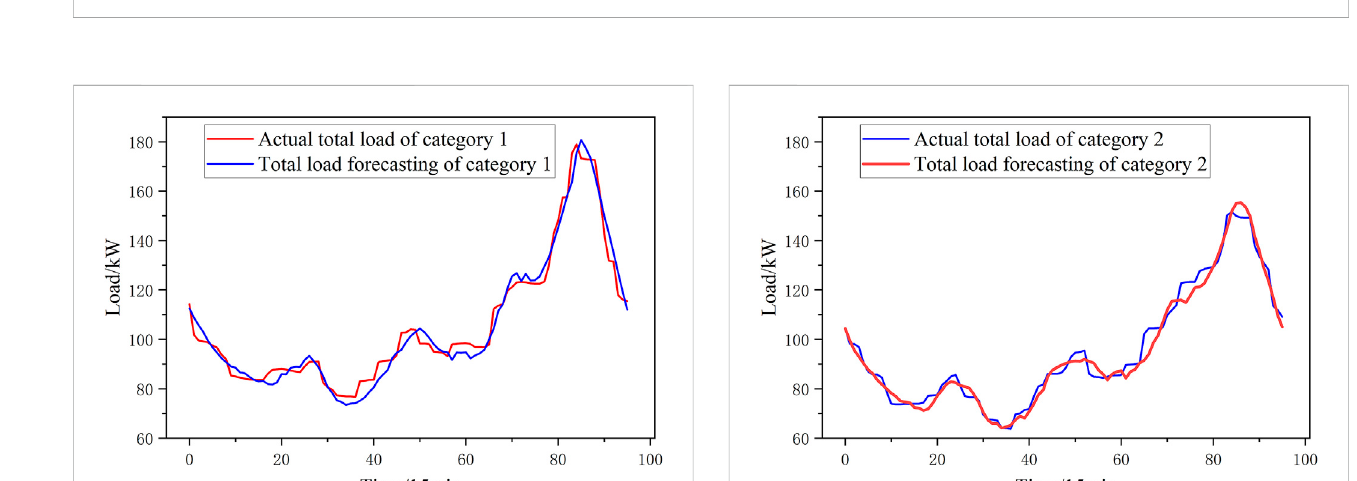
FIGURE 10 Forecasting result of Category 1.